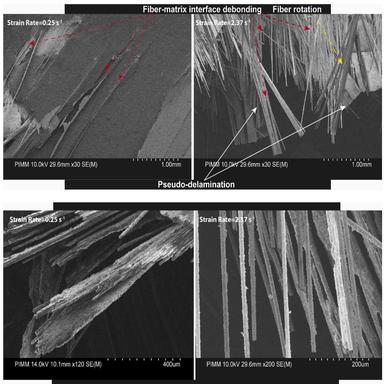
Fractography of RO-A-SMC composite under quasi-static and dynamic shear loading.